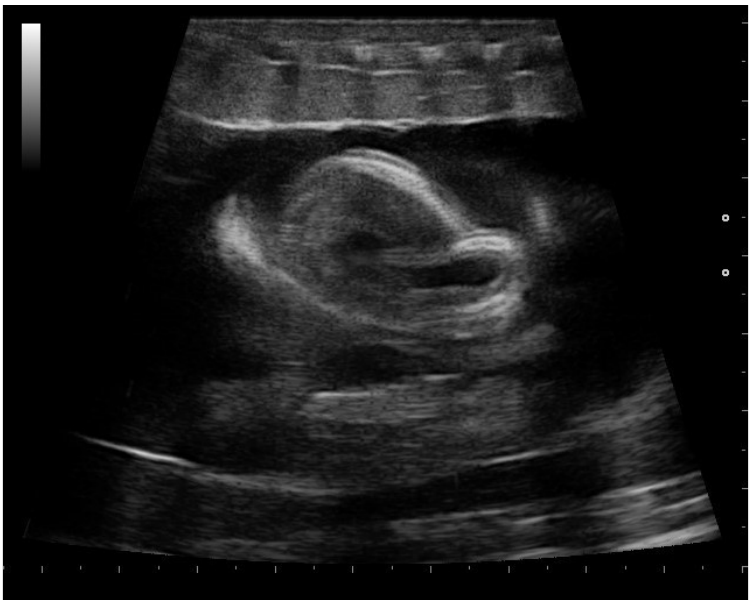
Figure 16. Gravid female boa 4 weeks before parturition. In all females who have given birth to live offspring, embryos moved, and their position varied greatly.